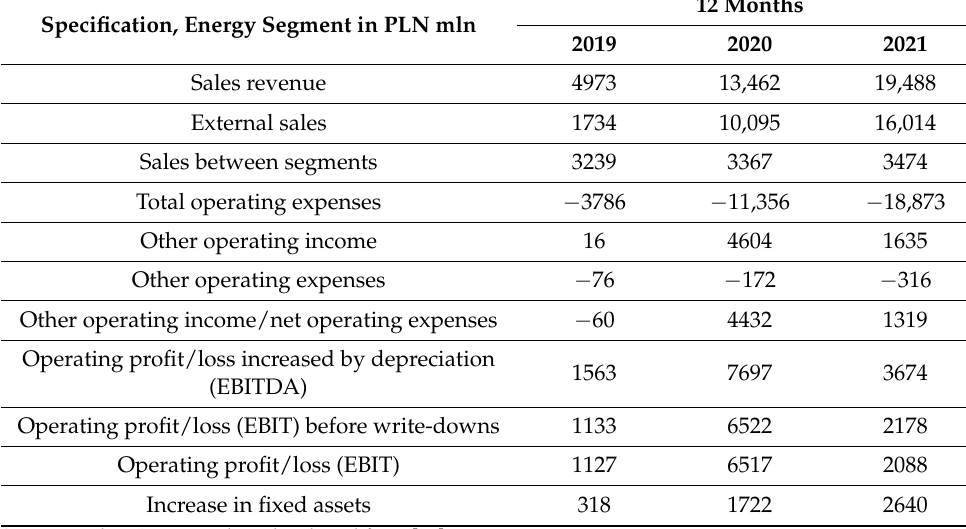
Table 6. Summary of selected financial data of PKN Orlen after Energa acquisition in the energy segment. Specification, Energy Segment in PLN